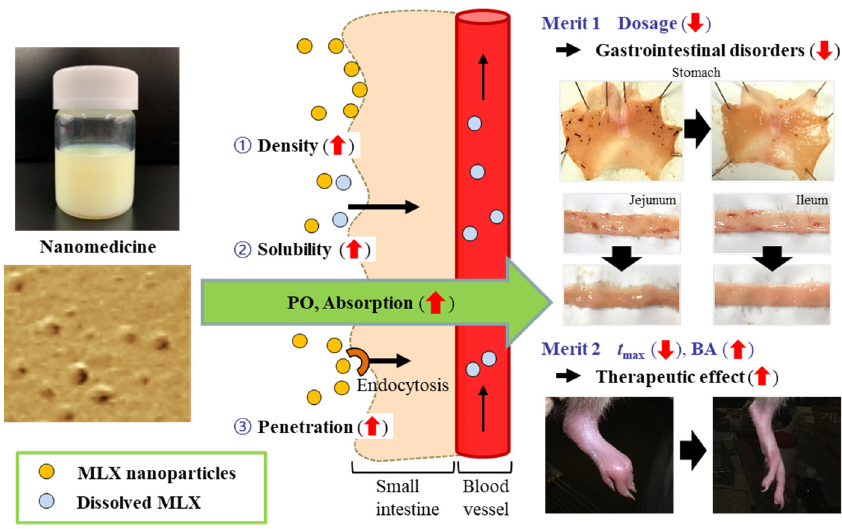
Scheme 2. Schematic illustration of the absorption mechanism and usefulness of orally administrated MLX-NPs. Supplementary Materials: Figure S1. Characteristics of MLX treated with or without the bead mill. (A) and (B), particle frequency of MLX-TDs (A), and MLX-NPs (B) by SALD-7100. Figure S2. XRD pattern of MLX with (B) or without (A) bead mill treatment. Figure S3. In vitro trans-epithelial penetration study using Caco-2 cell monolayers. (A) The effect of culture time on TER values of Caco-2 cell monolayers. (B) Particle frequency of MLX-NPs on the basolateral side. Figure S4. Intestinal penetration of MLX solution and MLX-TDs in the rats. (A) and (B), intestinal penetration of MLX through the jejunum (A) and ileum (B) treated with MLX solution at 4 °C and 37 °C conditions. (C) and (D), intestinal penetration of MLX through the jejunum (C) and ileum (D) treated with MLX-TDs at 4 °C and 37 °C conditions. Table S1. Pharmacokinetic analysis of the in vivo absorption of MLX formulations.